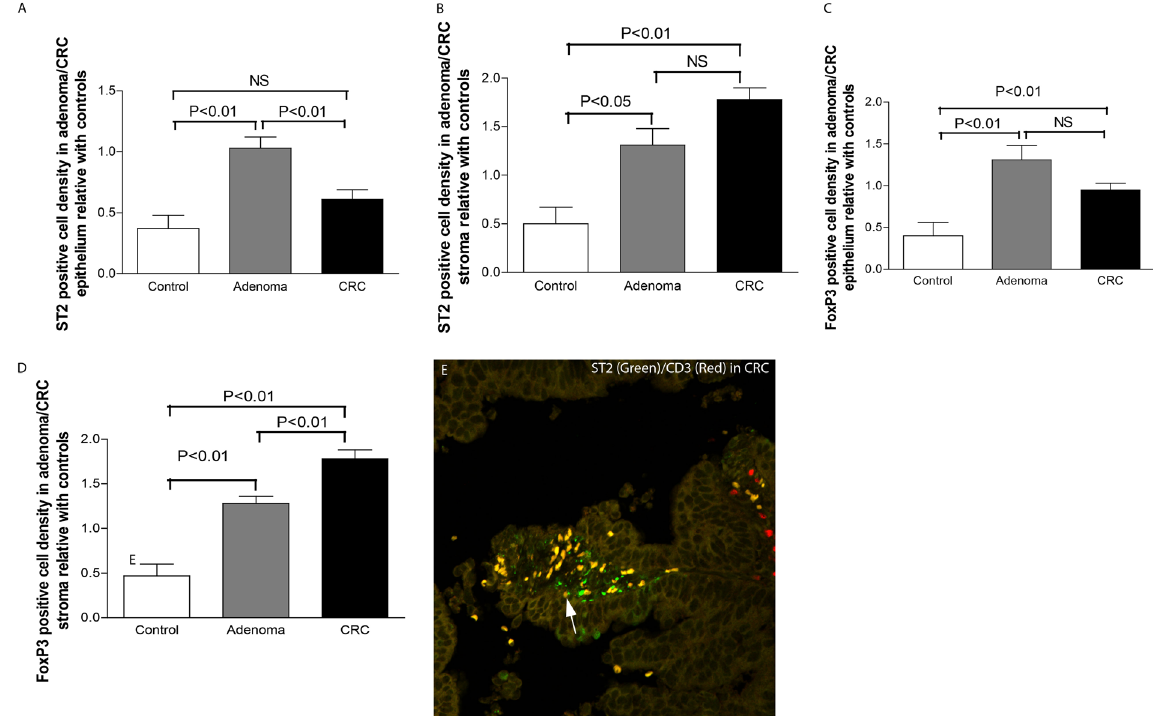
Figure 3. Density and phenotypical analysis of ST2-positive cells and FoxP3-positive Tregs in the adenoma/ CRC stroma. Semiquantitative data showed that the scores of ST2-positive cells ( A,B , epithelium and stroma respectively) and FoxP3-positive Tregs ( C,D , epithelium and stroma respectively) in both the adenoma and CRC were increased. The density of ST2-positive cells and FoxP3-positive Trges were even higher in the adenoma epithelium ( A,C , grey bar) and that in the CRC epithelium ( A,C , black bar). Further phenotypic analysis of ST2-positive cells ( green color in E,F ) in the adenoma/CRC stroma defined that most positive cells were colocalized with CD3-positive labelled ( red color in E ) T lymphocytes ( white arrow point in E ) and some were SMA-alpha-labelled ( red color in F ) myofibroblasts ( white arrow point in F ). ( E , F , confocal images, original magnification 200 × ; counterstaining was not